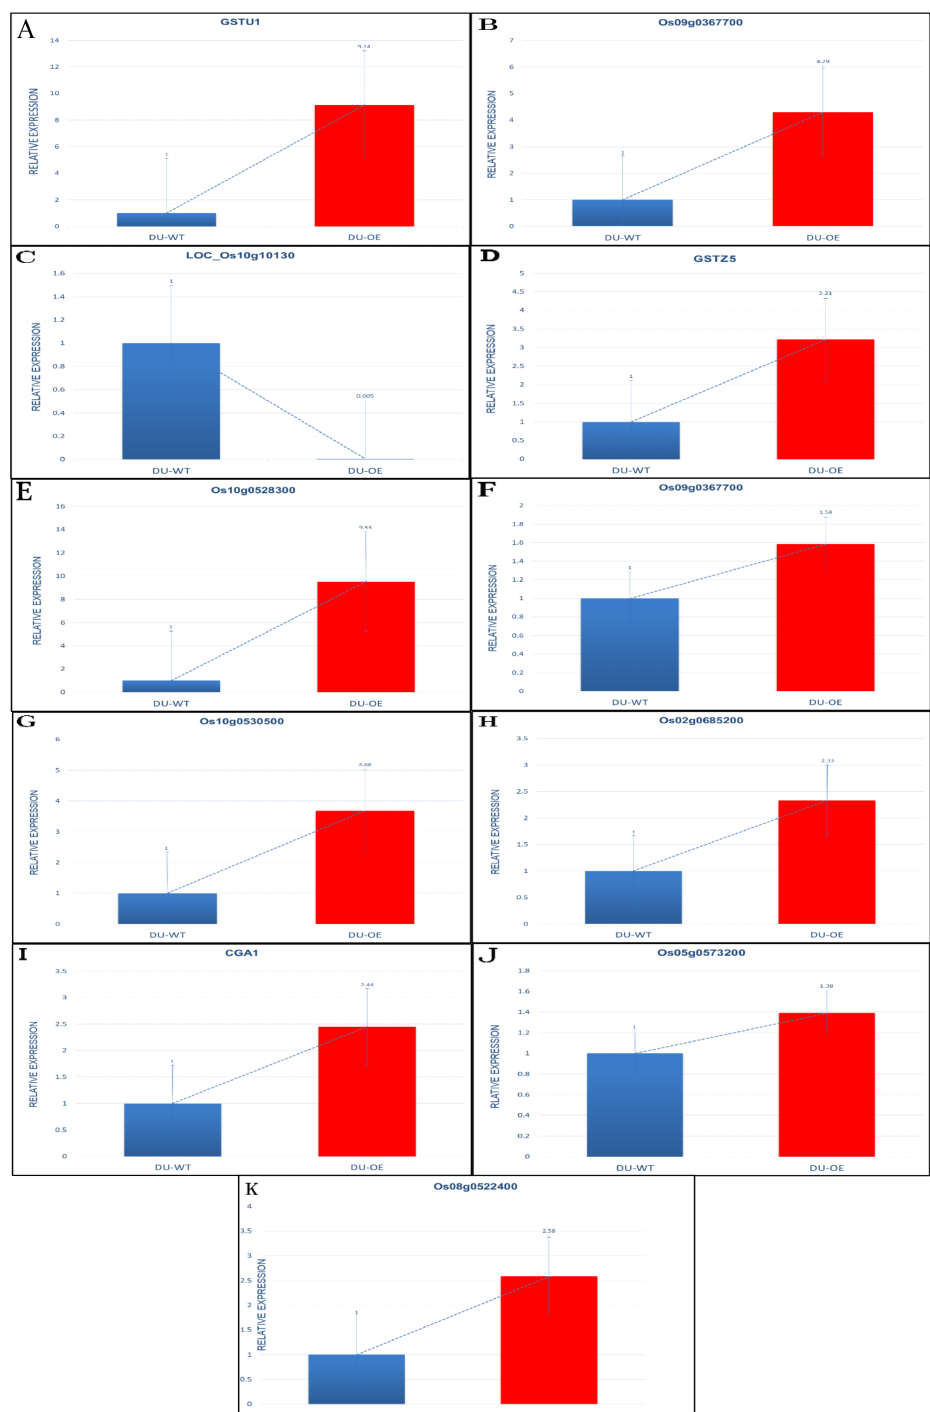
Figure 8. Fold change of gene expression levels in DU-OE as compared to DU-WT. GSTU1 ( A ); Os09g0367700 ( B ); LOC_Os10g10130 ( C ); GSTZ5 ( D ); Os10g0528300 ( E ); Os09g0367700 ( F ); Os10g0530500 ( G ); Os02g0685200 ( H ); Cga1 ( I ); Os05g0573200 ( J ); Os08g0522400 ( K